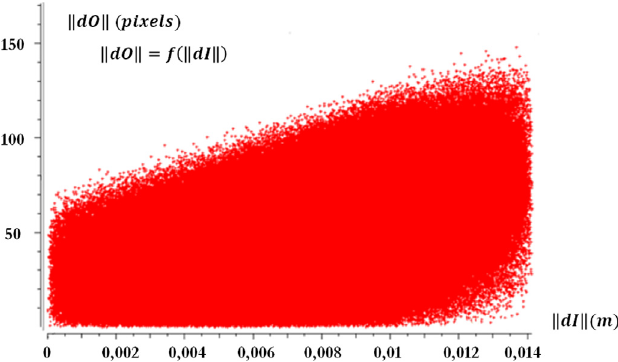
Fig. 23. Global uncertainties generated by the pinhole